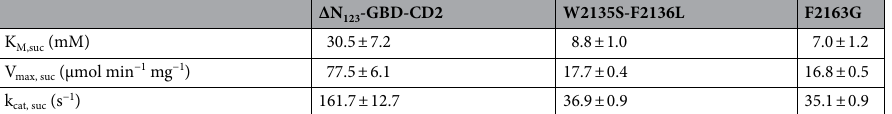
Table 1. Determination of kinetic parameters (K M , V max and k cat ) for sucrose (suc) hydrolysis of ΔN 123 - GBD-CD2 parental enzyme and mutants F2163G and W2135S-F2136L. Values were obtained by the least square fit of the Michaelis–Menten equation (Supplementary Table S1) and using increasing concentrations of sucrose (ranging from 10 to 300 mM), at pH 5.1 and 30 °C with 0.25 U/mL of purified